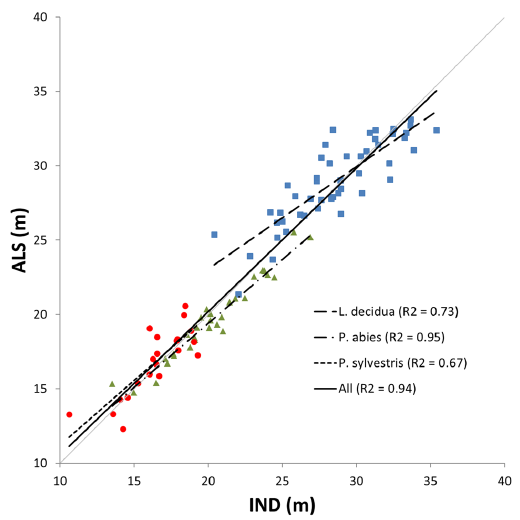
Figure 2. Regression analysis between tree height derived by airborne laser scanner data (ALS = ALS10) and tree height derived from indirect field-based measurement (IND), considering the whole dataset (All) and the three species separately. Each dot corresponds to a single tree (blue square = Larix ; green triangle = Picea ; red circle = Pinus ). Forests 2017 , 8 , 7